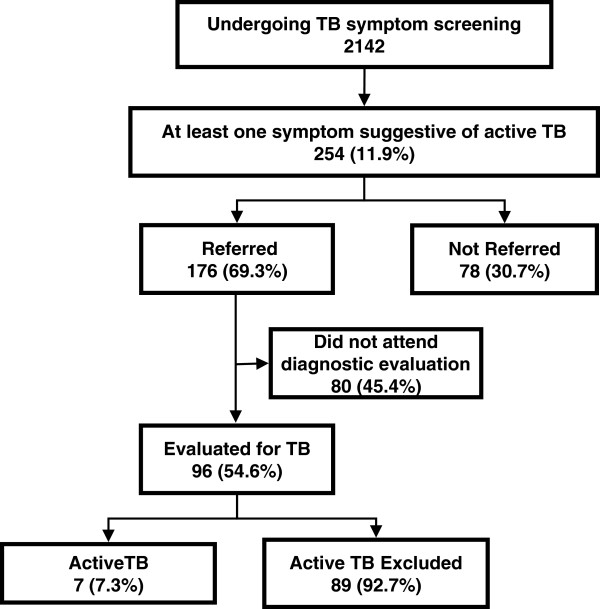
Flow diagram of the study.